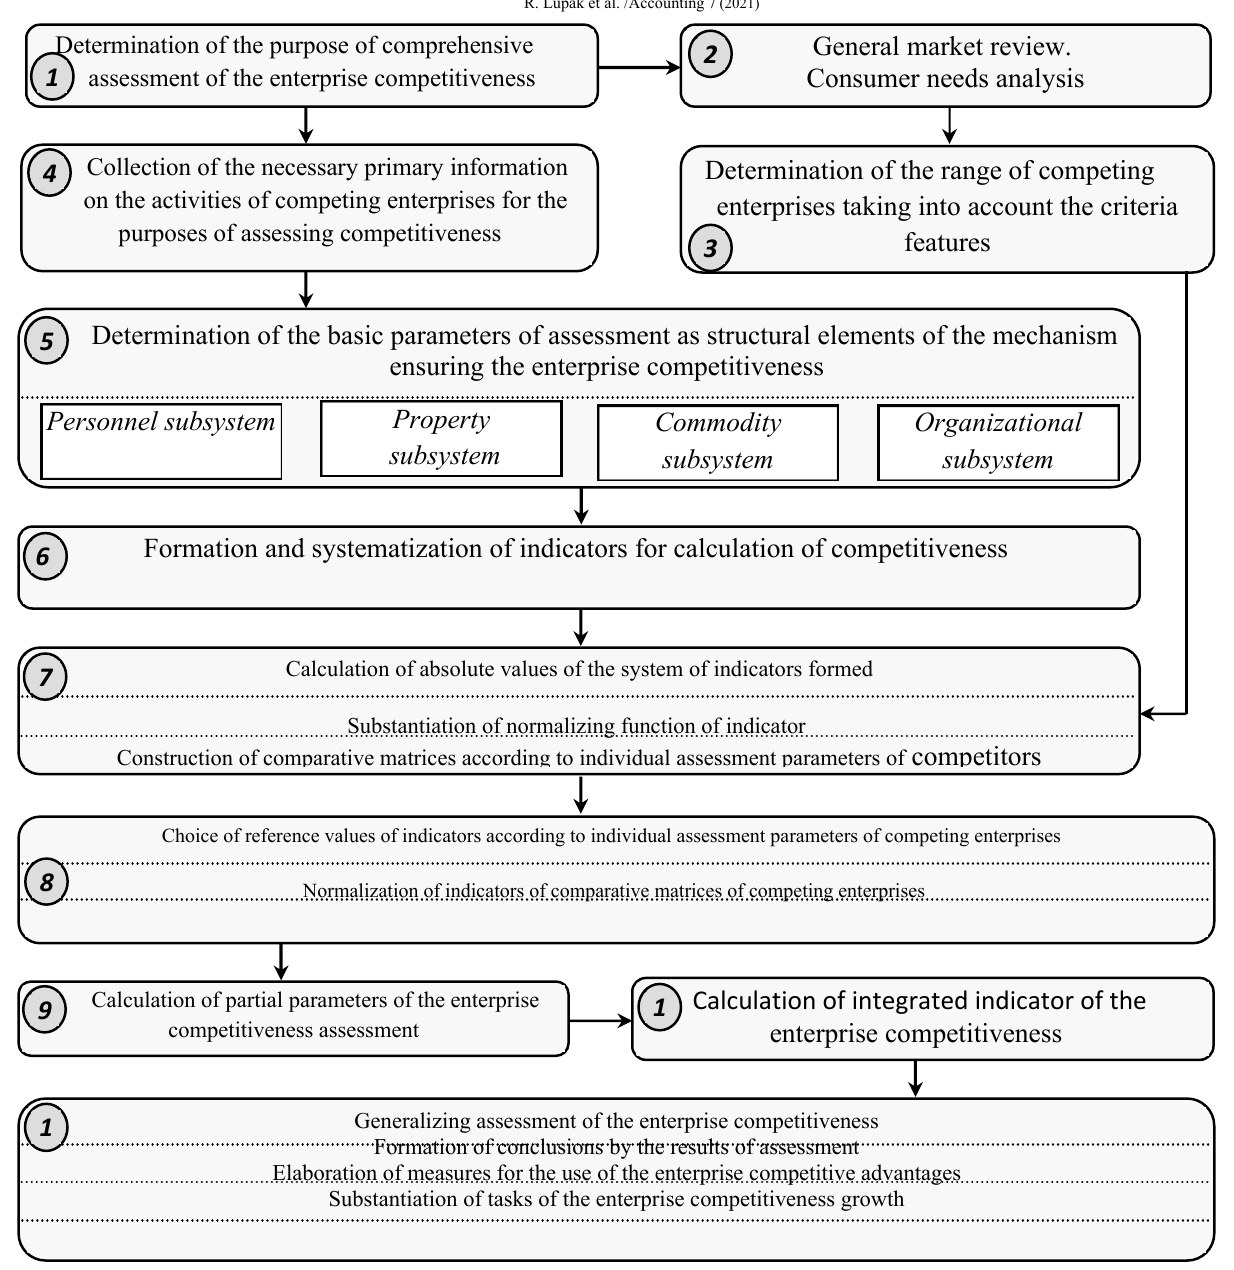
Fig. 1. Structural and logical pattern of the enterprise competitiveness comprehensive